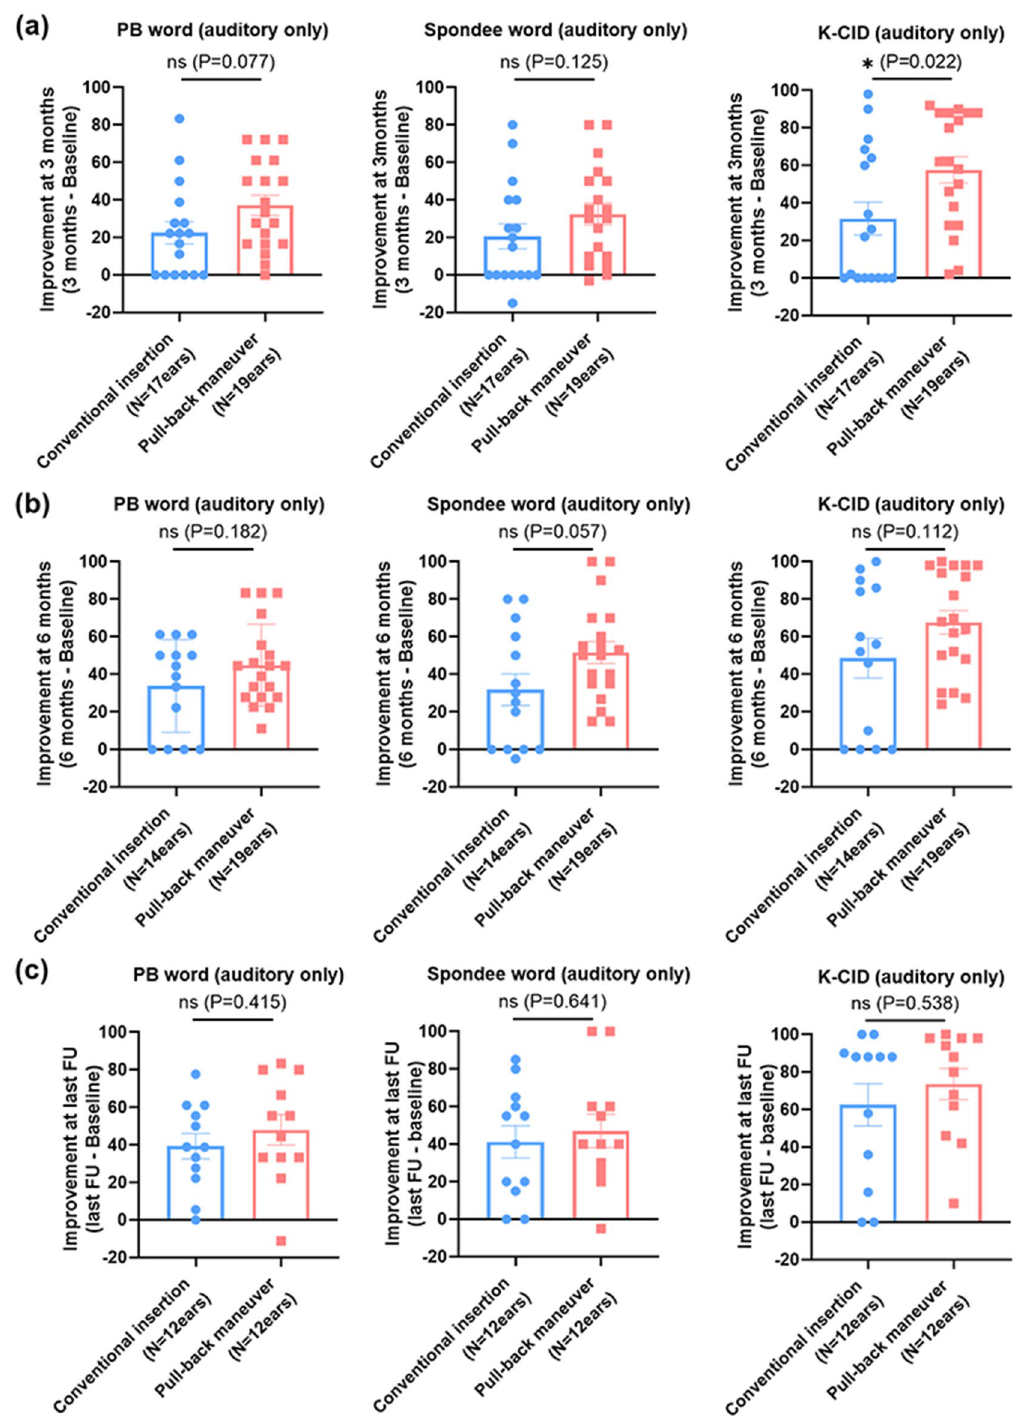
Figure 6. Comparison of serial changes in speech evaluation scores between the conventional insertion and pull-back maneuver groups in adult cochlear implant recipients (> 15-years old). The improvement refers to the difference in speech perception scores between preoperative (baseline) and postoperative three timepoint. ( a ) The improvement of word scores was seemingly higher in the pull-back maneuver group than in the conventional insertion group, but the difference did not reach a level of significance. However, a significant improvement of sentence scores (i.e., K-CID) during the postoperative 3-month follow-up was found in the pull-back maneuver group compared to that in the conventional insertion group. ( b , c ) The pull-back maneuver tended to elicit better speech perception in adult cochlear implantees compared to conventional insertion at 6 months and last follow-up postoperatively, although the effect was not statistically significant. The last follow-up refers to the speech evaluation test conducted between 6 and 12